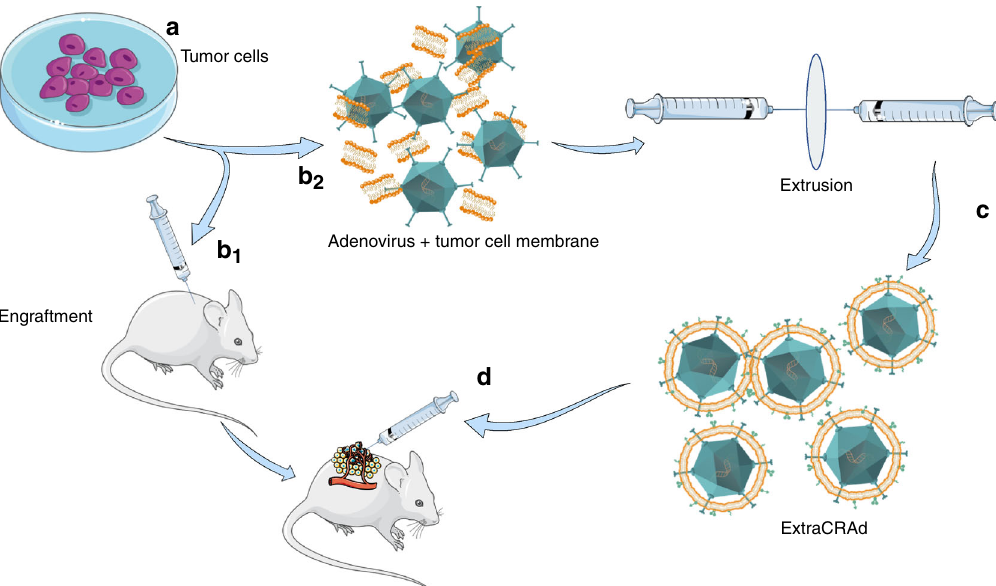
Fig. 1 ExtraCRAd, production and treatment. Tumor cells ( a ) were cultured and engrafted into mouse model ( b 1 ). We employed the same cell line to extract the cell membrane: cells were lysed, tumor membrane isolated and mixed with an oncolytic adenovirus serotype 5, with a 24-base-pairs deletion, carrying -CpG islands (i.e., A5- Δ 24-CpG) 60 ( b 2 ). Through the extrusion process the virus was arti fi cially wrapped with the cancer cell membrane to obtain ExtraCRAd ( c ). Finally, established tumors were treated with multiple intratumoral injections of ExtraCRAd ( d ). The petri dish, mice and syringes images are taken from Servier Medical Art, under Creative Commons Attribution 3.0 Unported